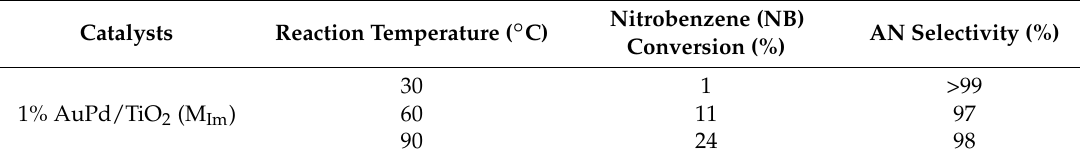
Table 1. Effect of reaction temperature for the solvent-free hydrogenation of nitrobenzene over a 1% AuPd/TiO 2 (M Im ) catalyst a . Catalysts Reaction Temperature ( ◦ C)